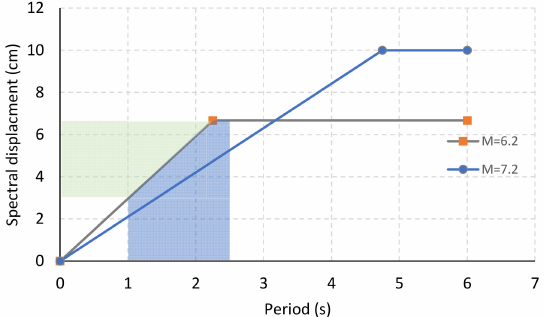
Figure 12. Displacement spectral demand for two earthquakes with magnitudes 6.2 and